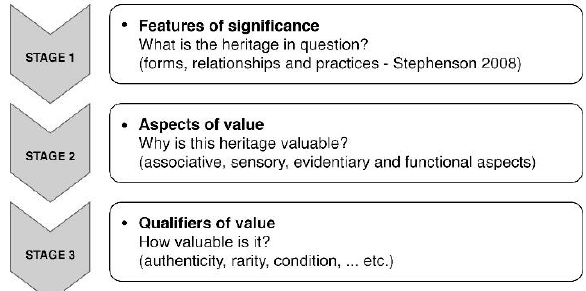
Figure 3. This figure represents the framework elaborated by